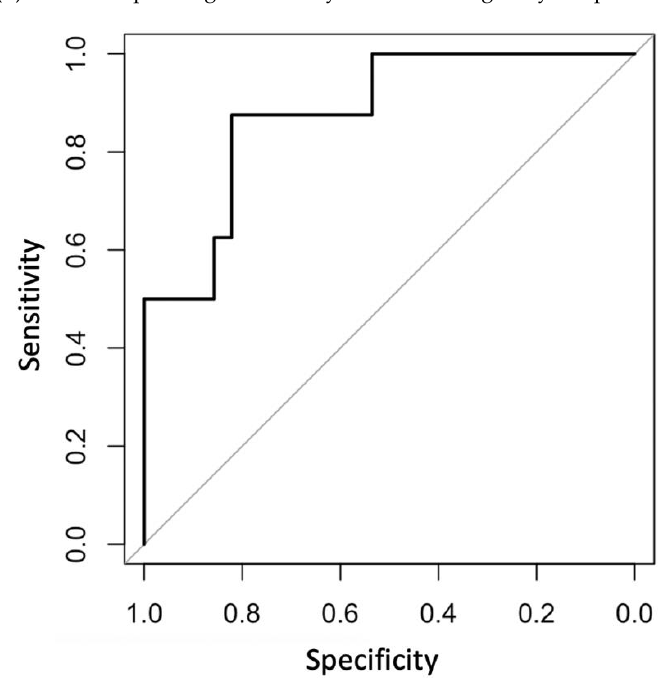
Figure 1. ( a ) Receiver operating curve analysis of cats to predict their death within 12 h using body temperature. ( b ) Receiver operating curve analysis of cats to predict their death within 12 h using partial venous pressure of carbon dioxide.